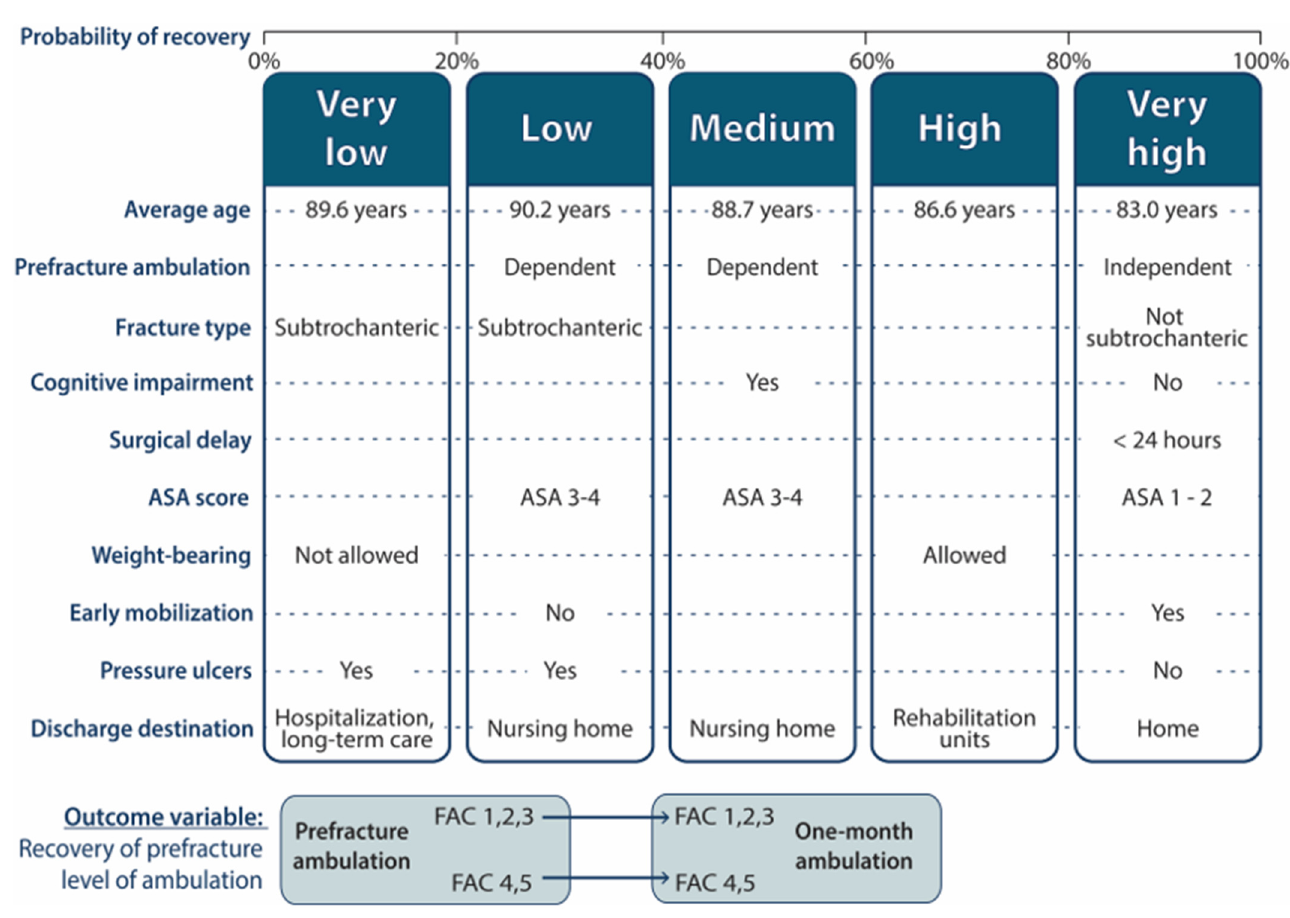
Figure 5. Clusters predicting the probability of functional recovery (very low; 0–20%; low, 20–40%; medium, 40–60%; high, 60–80%; very high, 80–100%), The boxes show the average age of the patients include in each cluster, as well as the most relevant features for the variables included in the model. Dashed lines represent transitions in which the difference between one cluster and the next were not relevant for the variable. Below: definition of the outcome variable as recovery of prefracture ambulation at one month, depending on FAC categories (1,2,3 vs. 4,5).